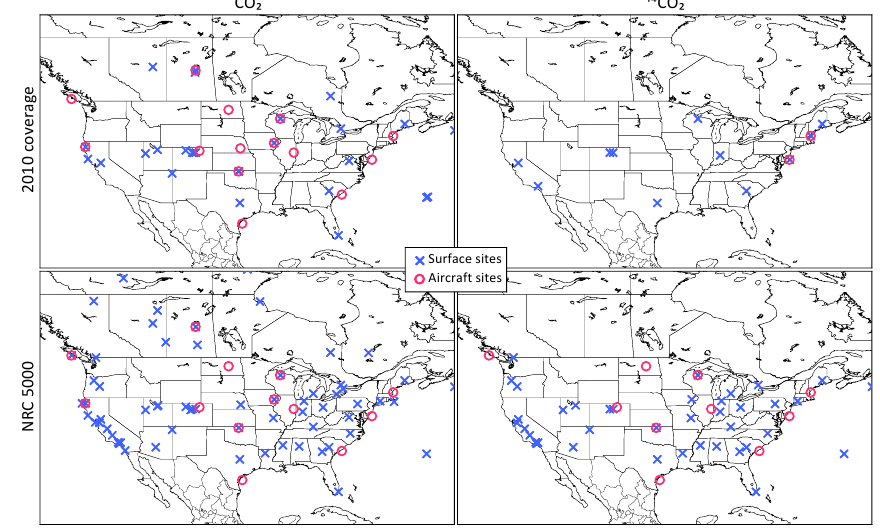
Figure 3. The sites for which CO 2 and 14 CO 2 measurements were simulated and then assimilated in our OSSEs for two different coverage scenarios, 2010 and NRC 5000, as described in the